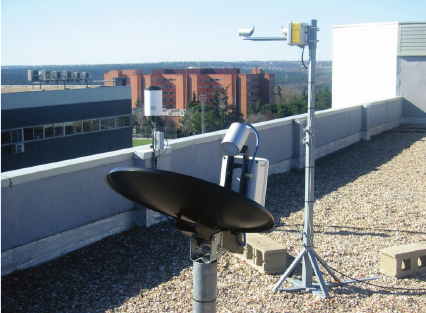
Figure 1: Instrumentation used: in the foreground, the Micro Rain Radar (MRR); in the background to the left, a rainfall gauge; and to the right, an optical